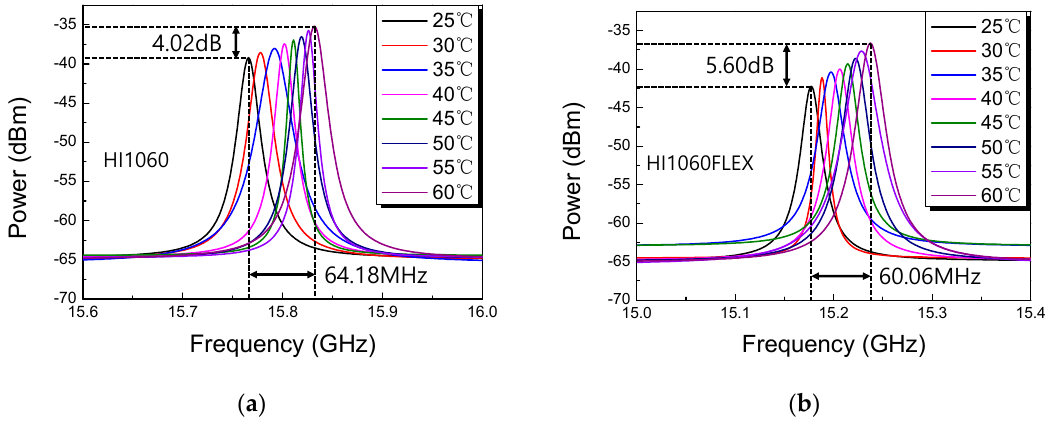
Figure 5. Measurements of Brillouin spectra as a function of temperature. ( a ) HI1060, ( b ) HI1060FLEX. Here the input signal power was 55 mW at λ = 1064 nm and the fiber lengths were 500m.